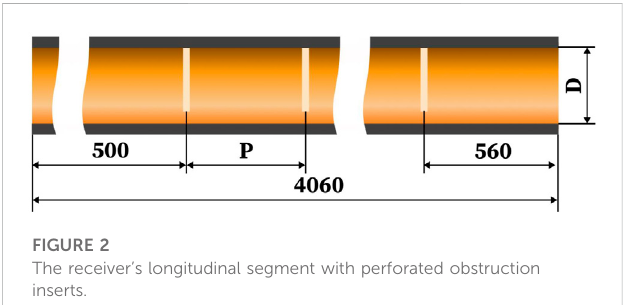
FIGURE 2 The receiver ’ s longitudinal segment with perforated obstruction inserts.